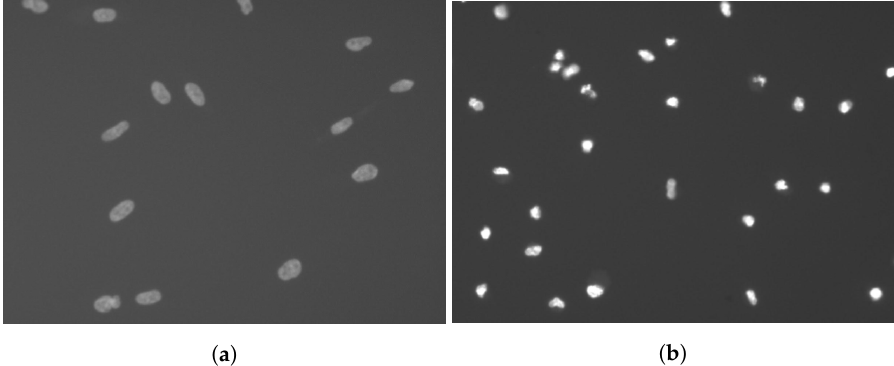
Figure 2. 4’,6-diamidino-2-phenylindole (DAPI) images, which show only cell nuclei, are used for nuclei detection and cell separation: ( a ) shows nuclei of living cells, ( b ) dead